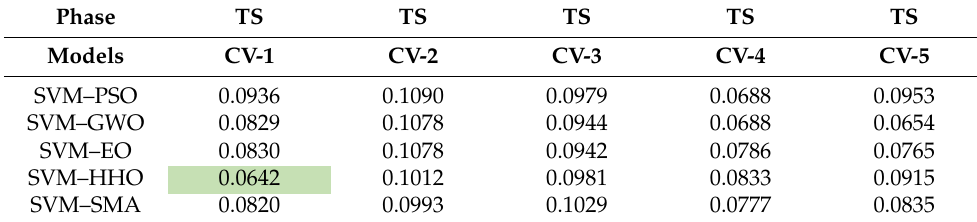
Table 5. Performance of five-fold cross-validation (testing